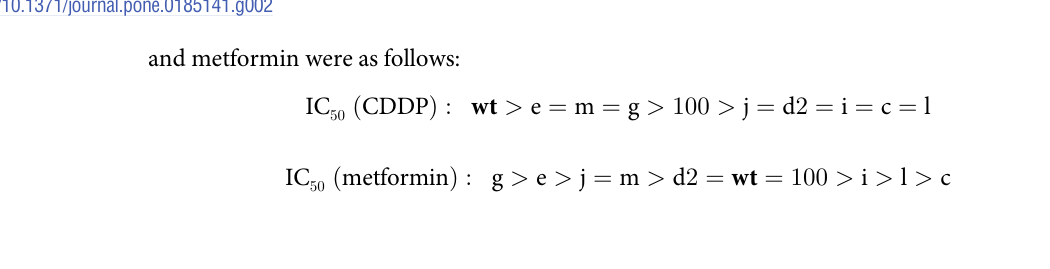
PLOS ONE | https://doi.org/10.1371/journal.pone.0185141 September 19,